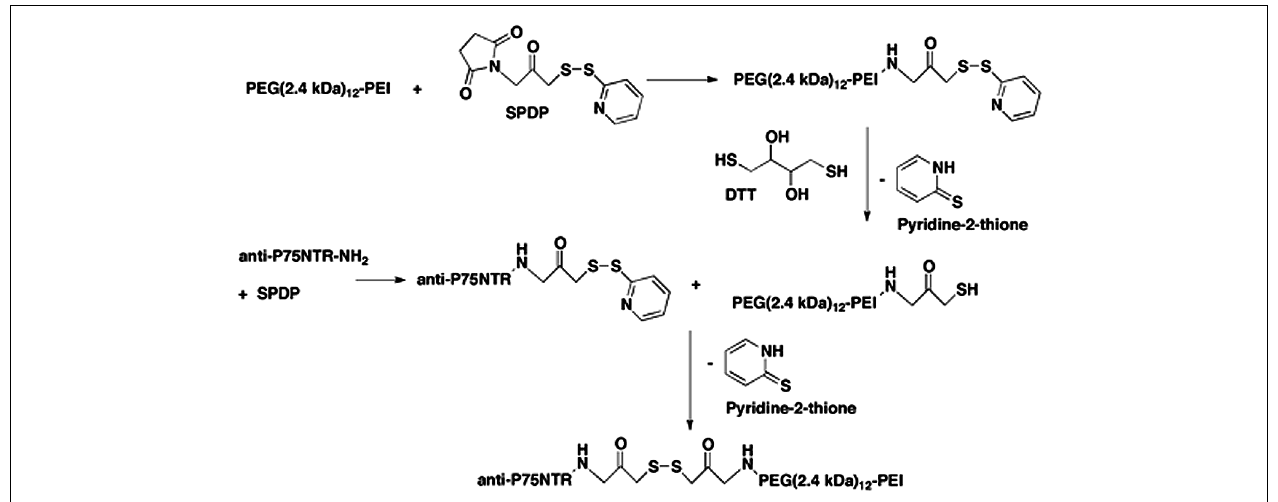
FIGURE 2 | Stepwise synthesis of the targeted nanoconstructs.